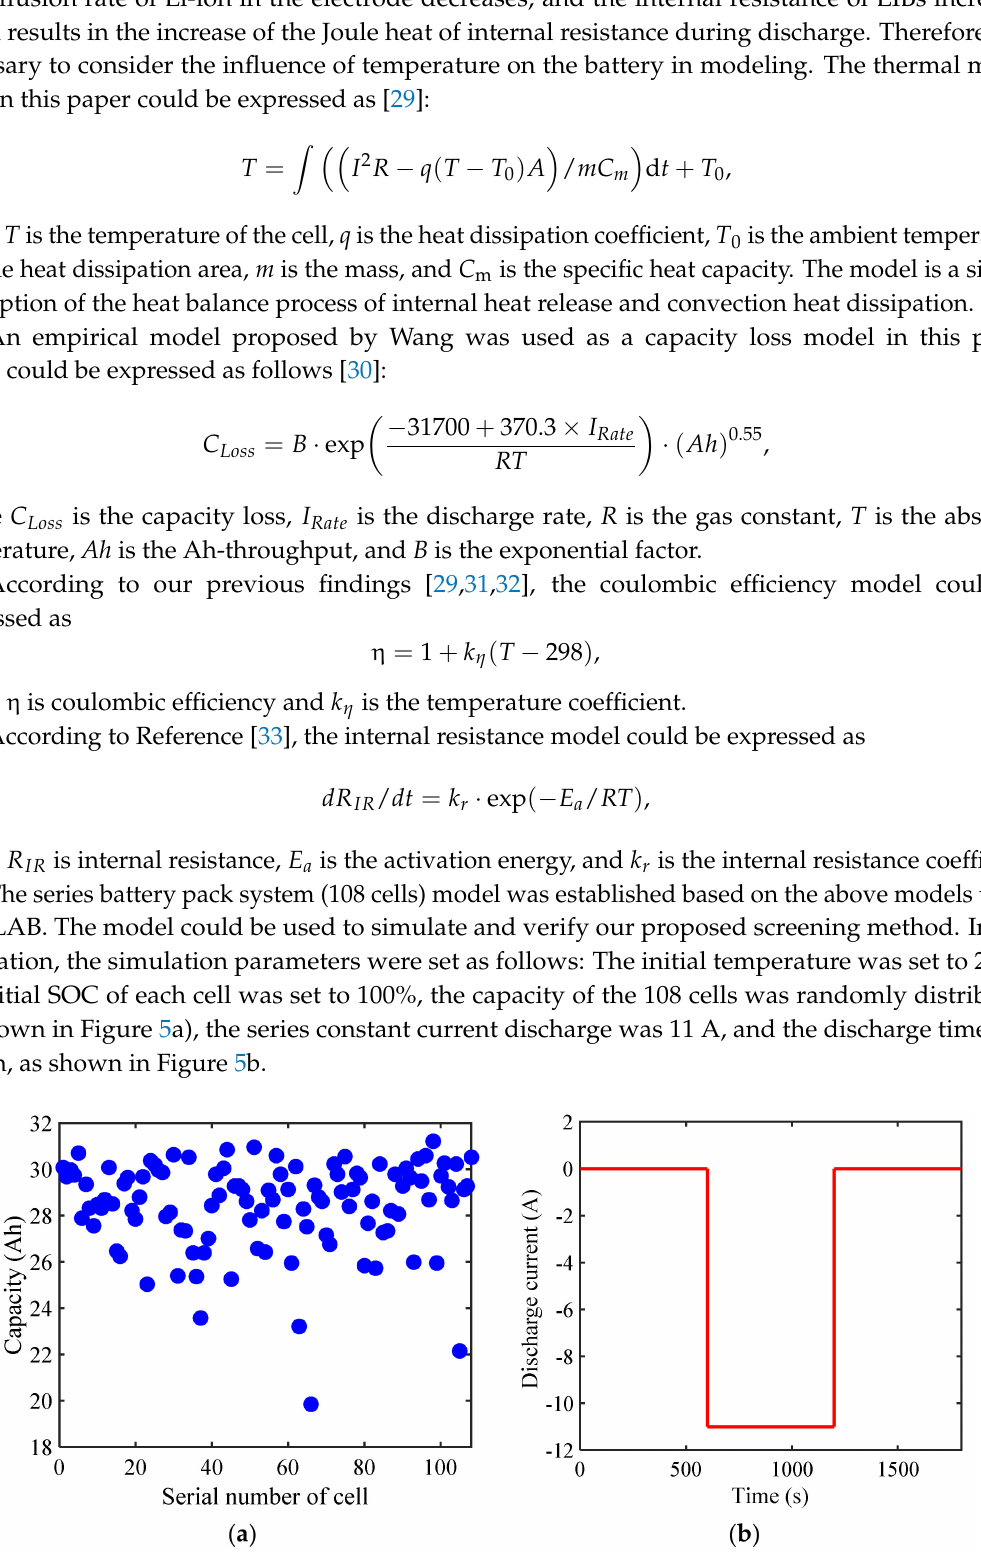
Figure 5. Simulation parameters: ( a ) Real capacity of the 108 cells; ( b ) constant current discharge curve of series battery